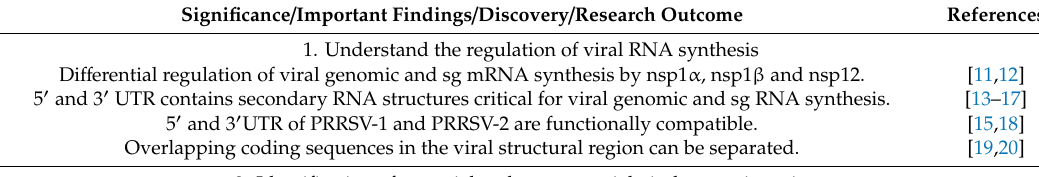
Table 1. Ten important applications of PRRSV reverse